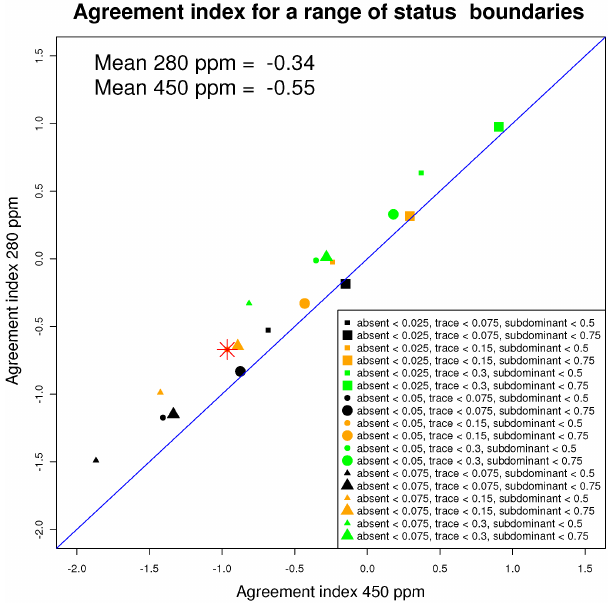
Figure E1. Agreement index (AI) values for the 280 and 450ppm runs for different fractional boundaries of the AI